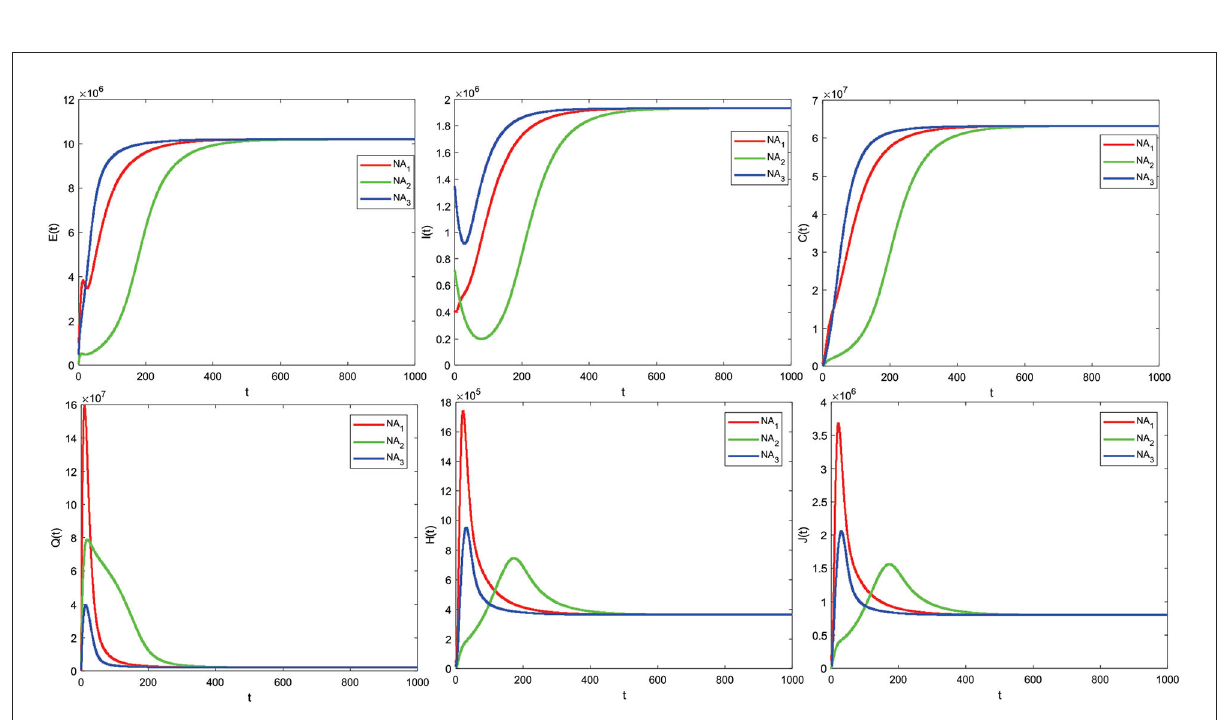
FIGURE5 The COVID-19 model solution graph for R 0 >